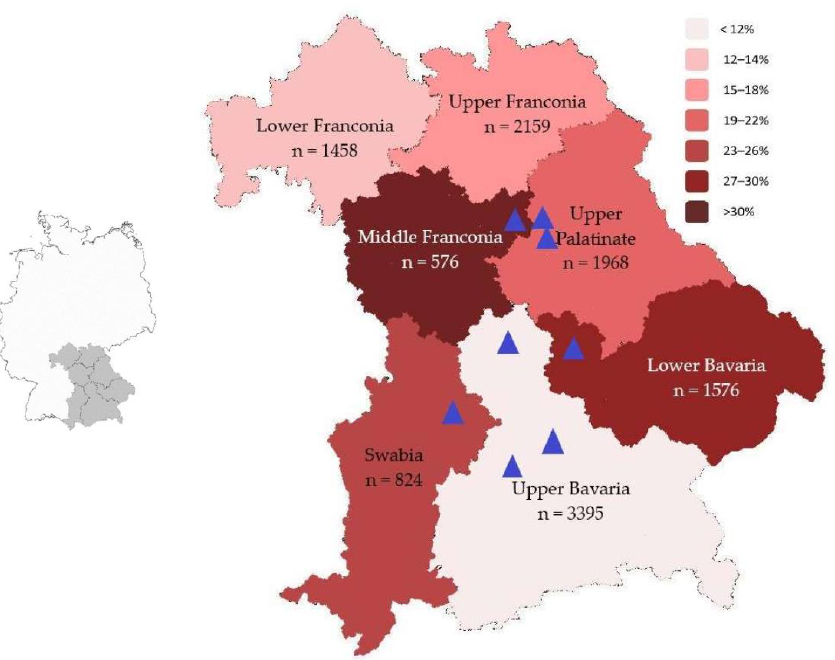
Figure 1. Map of Germany with Bavaria shaded in grey ( left ); map of Bavaria ( right ) showing serologic incidence and geographic distribution regarding brucellosis in wild boars from 2019 to 2021. Incidences are represented in a color scale from low ( light ) to high ( dark ). The total number of examined individuals (n) is shown for each district. The blue triangles represent direct pathogen detection by PCR.